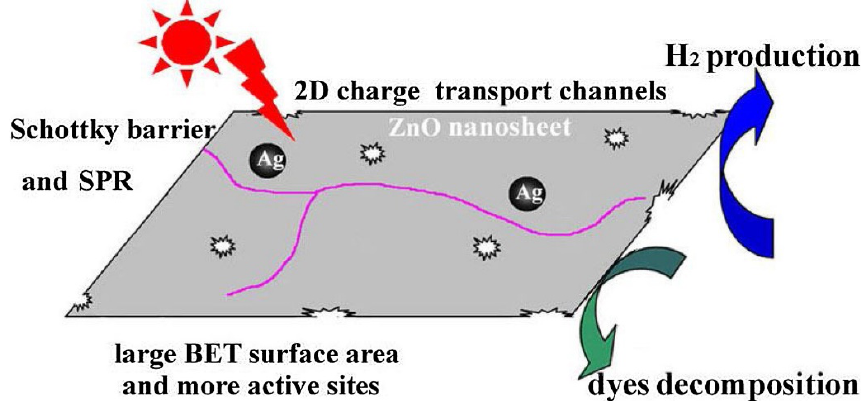
Figure 9. The architecture of Ag/ZnO and its photocatalytic mechanism, adapted from [44].